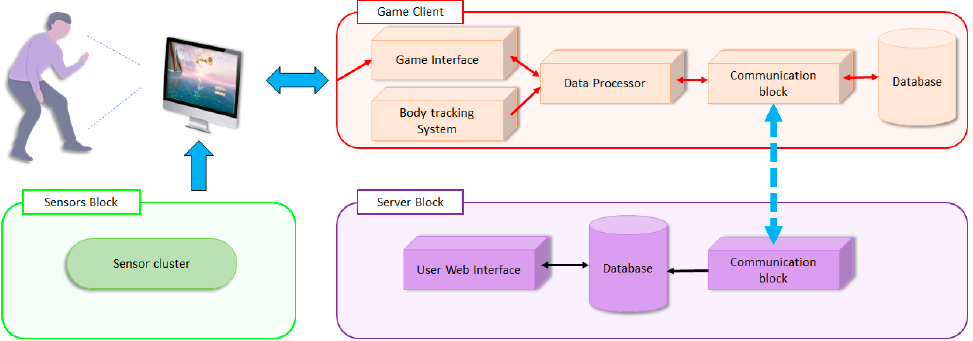
Figure 3. Main system